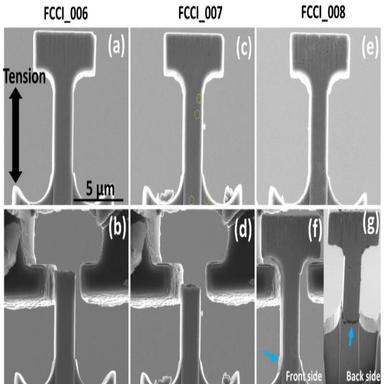
SEM micrographs before and after micro-tensile testing for FCCI region specimens. There are no observable microstructural defects on FCCI_006 surface, but some defects observed on FCCI_007 (yellow dashed circle) and even more abundance defects on FCCI_008.